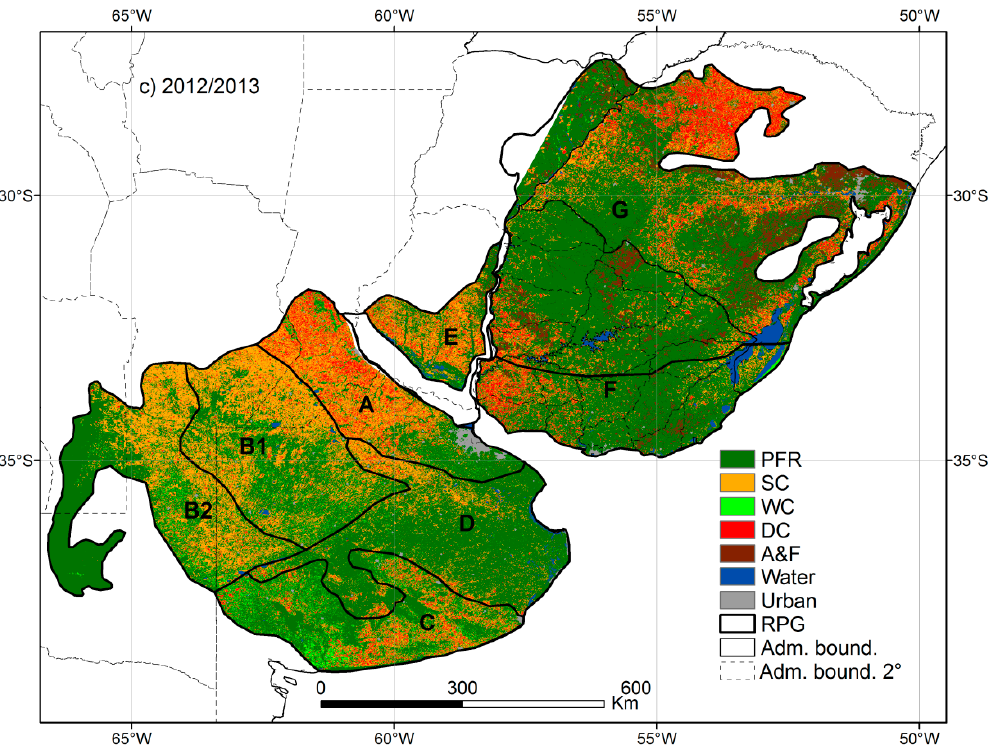
Figure 4. LULC classifications of the Río de la Plata Grasslands for 3 agricultural years, selected due to the absence of major errors. a) 2001/2002, b) 2006/2007 and c) 2012/2013.PFR: Perennial Forage Resources, SC: Summer Crops, WC: Winter Crops, DC: Double Crops, A&F: Afforestations and Forest;. RPG: Rio de la Plata Grasslands; Adm. bound.: administrative boundaries; Adm. bound. 2°: Second order administrative boundaries. ( A ) Rolling Pampa; ( B1 ) Flat Inland Pampa; ( B2 ) West Inland Pampa; ( C ) Southern Pampa; ( D ) Flooding Pampa; ( E ) Mesopotamic Pampa; ( F ) Southern Campos; ( G ) Northern Campos.